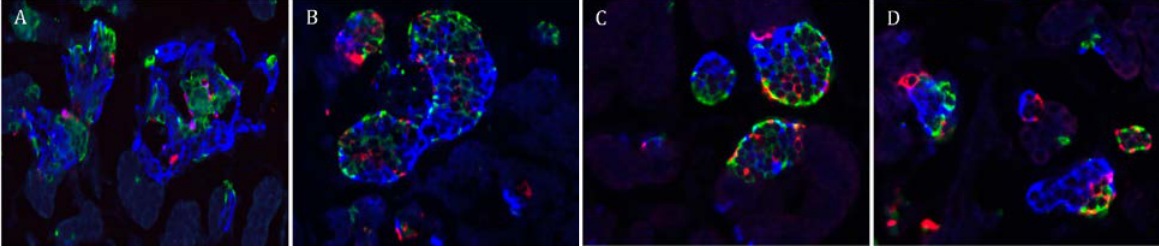
Figure 3. Immunostaining for pancreatic endocrine cells. Representative micrographs for pancreatic endocrine cells are depicted for control-sham ( A ); control-AD ( B ); IUGR-sham ( C ); and IUGR-AD ( D ) fetuses. The pancreatic sections were immunostained for insulin (β-cells; blue), glucagon (α-cell; green) and the combination of somatostatin and PP (δ-cells and F-cells;